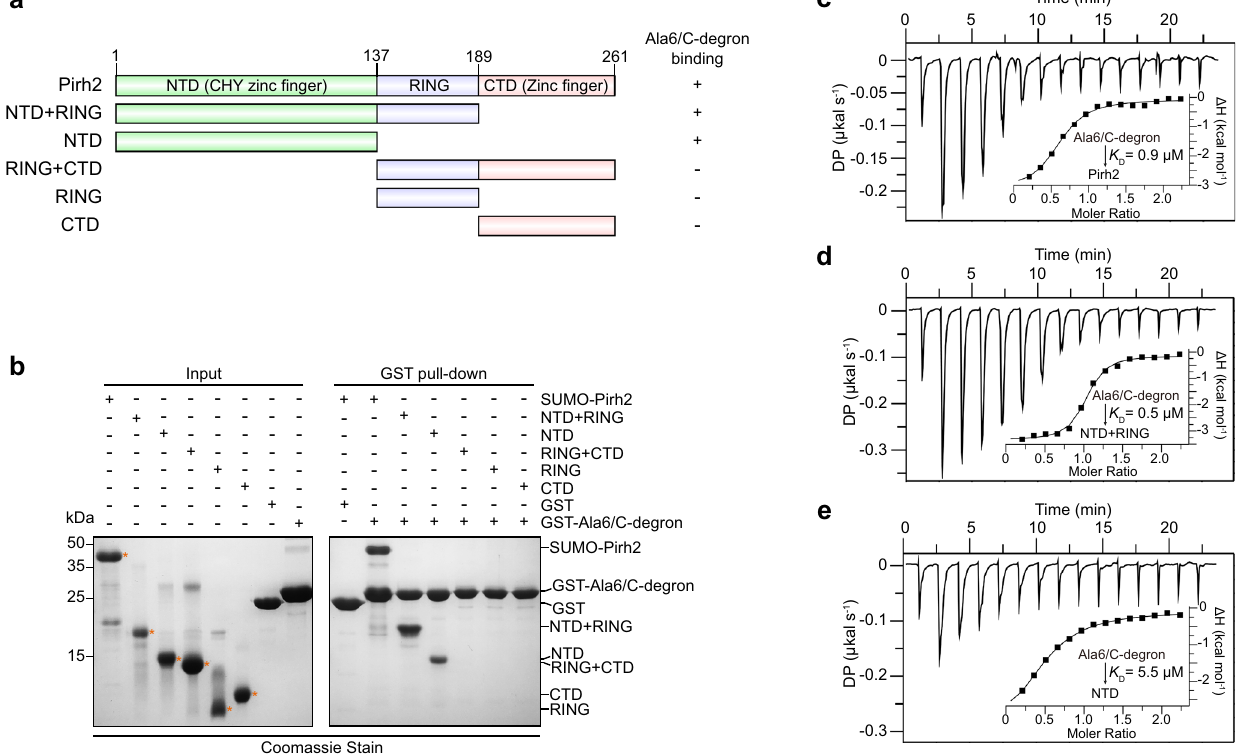
Fig. 1 | The NTD and RING of Pirh2 coordinate in Ala6/C-degron binding. a DomainarchitectureofhumanPirh2andfragmentsofPirh2usedintheGSTpull- down experiment. NTD, N-terminal domain; CTD, C-terminal domain. RING, really interestingnewgene. b GSTpull-downassayusingGST-fusedAla6/C-degrontopull